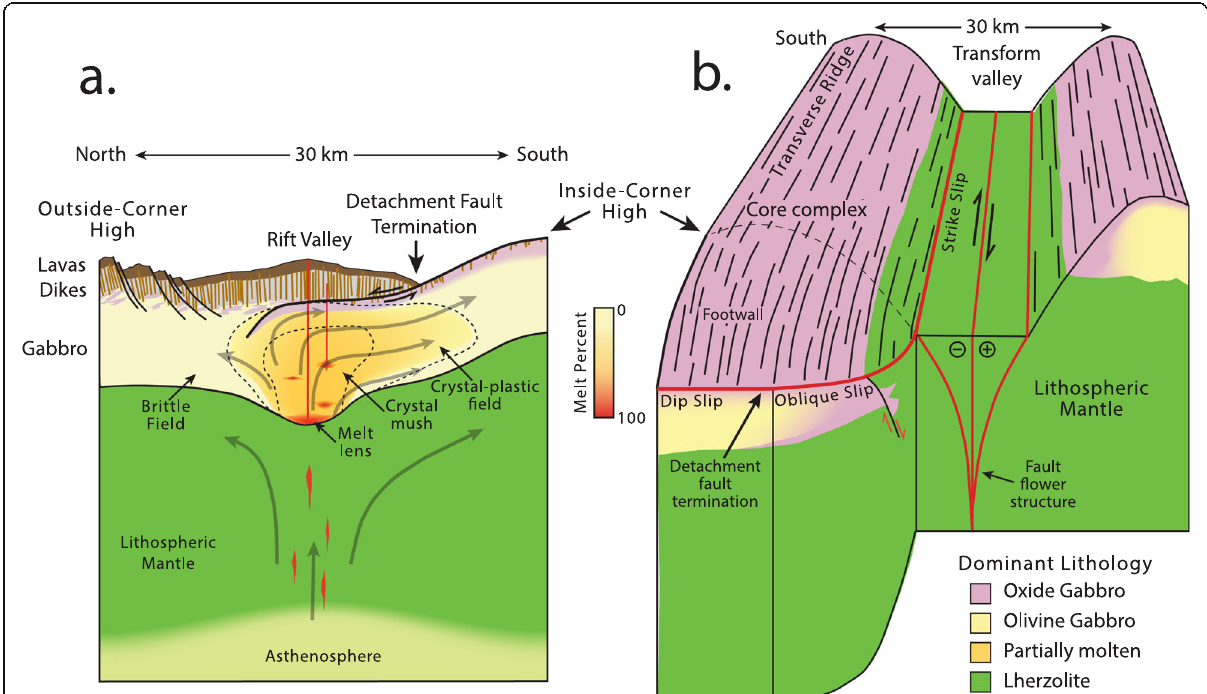
Fig. 48 Orthogonal cartoons of a tectonic model for Atlantis Bank emplacement: a N-S cross-section of the paleo-rift valley and opposing outside and inside-corner highs ~ 15 km east of the ridge-transform intersection. The gabbro above the melt lens migrates diapirically as a mush, by crystal-plastic flow at low melt %, and then by solid-state crystal-plastic deformation. Small higher level intrusions locally crosscut the fabric of the rising gabbro diapir as an ongoing process. Heavy red line shows the detachment fault cutting through the dike-gabbro transition into partially molten gabbro. It extends beneath the rift valley, resulting in fault capture and asymmetric spreading of the lower crust to the south parallel to the transform. Late, interstitial melt moved upward (and laterally) to create an oxide gabbro rich zone in the upper 500 m of the lower crust and migrated into the detachment fault zone to form an oxide gabbro rich mylonite that extends over the core complex. Gray arrows show lithospheric flow which extends up to the dike-gabbro transition. Fields for brittle, crystal-plastic, and crystal mush deformation and flow are separated by the thin dashed lines. Note that the crystal-plastic field overlaps the partially molten region at low melt percent. b Three- dimensional cartoon looking from north to south at right angles to the cross-section in “ A ” . Late E-W brittle faulting during lithospheric rollover and mass wasting of the transverse ridge are excluded for simplicity. Unmodified by mass wasting in the cartoon, the detachment fault footwall smoothly curves downward to the transform floor across the gabbro-mantle contact. It also extends downward from the inside-corner high to its termination on the rift valley floor. Thus, the detachment fault termination (heavy red, dashed line) extends along the foot of the rift valley wall, then curves, and progressively evolves from a normal fault, to oblique slip, to strike-slip at the base of the transform wall. The extension of the fault down below the transform valley (heavy red line) forms one branch of an active negative fault flower structure that forms the plate boundary between the African and Antarctic